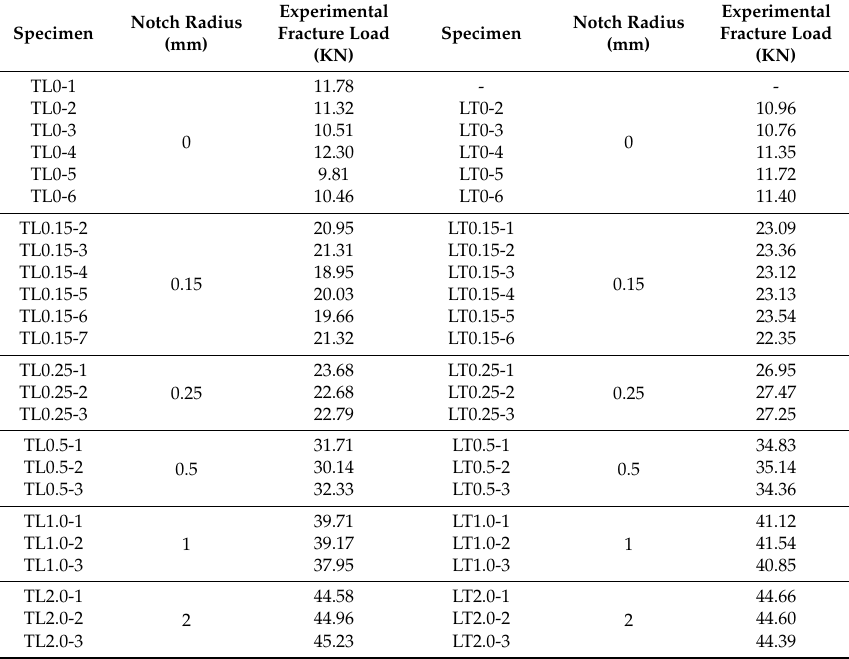
Table 5. Experimental fracture loads for TL and LT specimens. Reproduced with permission from Madrazo, V.; Cicero, S.; Carrascal, I.A. Eng. Fract. Mech . Published by Elsevier, 2012